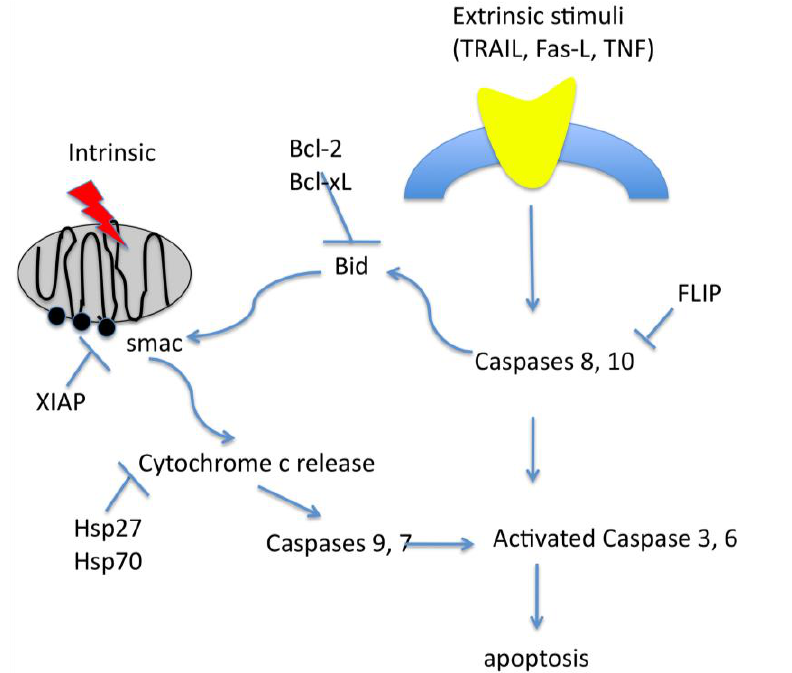
Figure 2. Brief schematic representation of intrinsic and extrinsic apoptotic